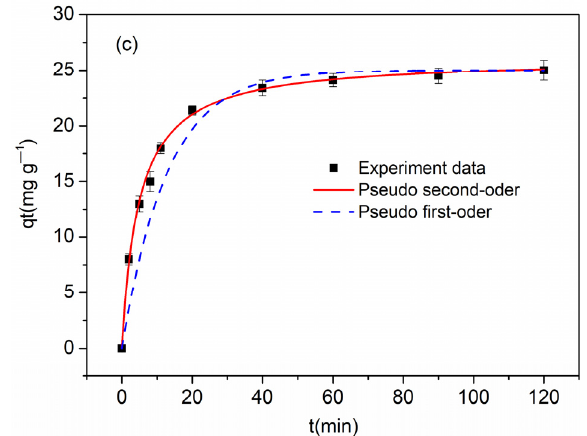
Figure 6. Kinetics of Cu(II) adsorption on ( a ) FBPC 2.5-900-1% , ( b ) FBPC 2.5-900-2% , and ( c ) FBPC 2.5-900-4% . Adsorbent dose = 0.35 g L − 1 ; shaking speed = 300 rpm; shaking time = 5–120 min; initial Cu(II) concentration = 10 mg L − 1 ; pH = 5; and temperature = 298 K. Table 2. Isotherm adsorption parameters for the process of Cu(II) removal by the FBPC samples. Pseudo-First-Order Equation Pseudo-Second-Order Equation Sample